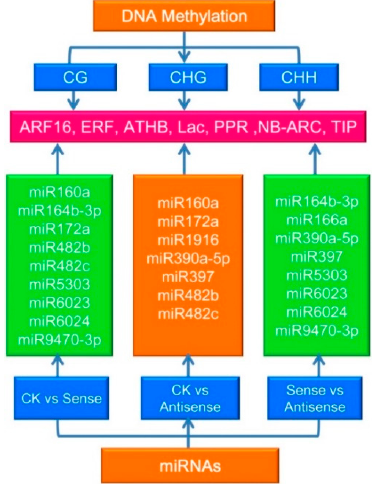
Figure 9. The DNA methylation and microRNA (miRNA) conjoint analysis of different groups. One hundred and ninety-one target genes with different levels of methylation were found. The DEGs of the miRNAs were analyzed and 9, 7, and 8 differently expressed miRNAs were found for each group, respectively.